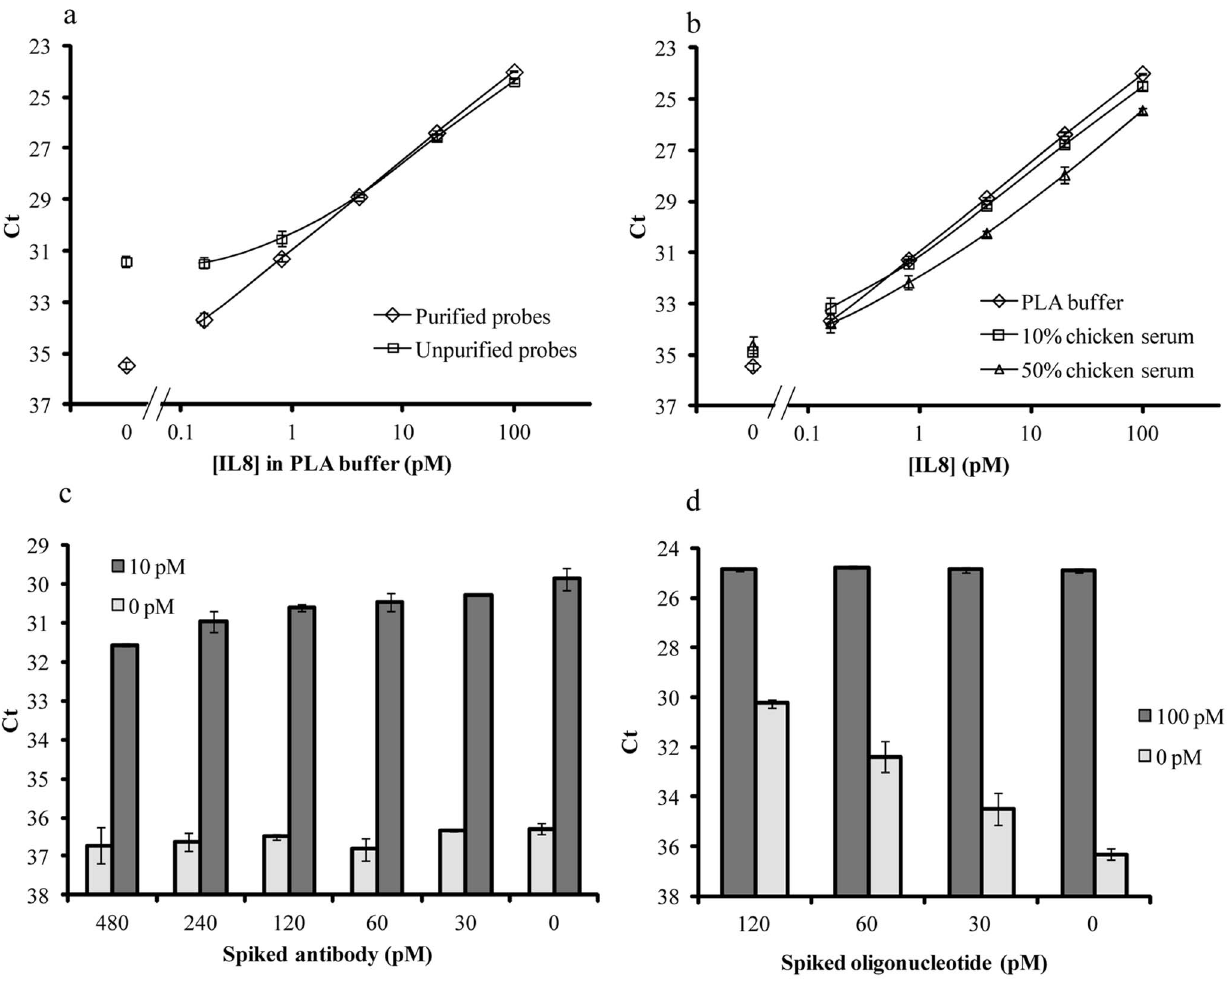
Figure 3. Solution phase PLA for detection of recombinant human IL8. (a) Detection of IL8 in PLA buffer with 60 pM pure anti-IL8 DNA conjugates (diamonds) and 60 pM unpurified anti-IL8 DNA conjugates (squares). (b) Detection of IL8 in PLA buffer (diamonds), 10% chicken serum (squares) and 50% chicken serum (triangles) using 60 pM pure anti-IL8 DNA conjugates. (c) Different amounts of unconjugated anti-IL8 (at a final concentration from 480 pM to 0 pM) were spiked in 60 pM of pure anti-IL8 conjugates. This series of mixes of probes were used in samples with either 10 pM or 0 pM IL8 in PLA buffer. (d) Different amounts of unconjugated oligonucleotides (Arm1 and Arm2 at a final concentration from 120 pM to 0 pM) were spiked in 60 pM of pure anti-IL8 conjugates. The probe mixes were employed in samples with 100 pM or 0 pM IL8 in PLA buffer. Error bars (a and b) indicate standard deviation from quadruplicate reactions and error bars (c and d) indicate standard deviation from duplicate reactions.